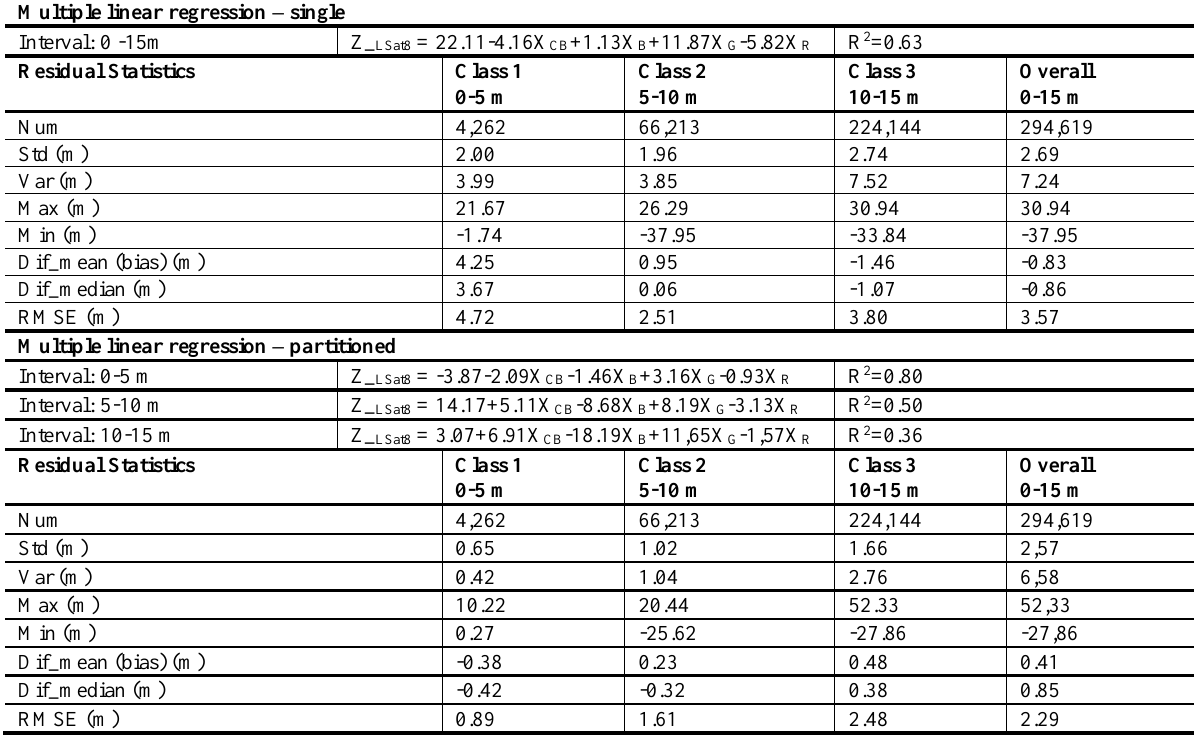
Table 1. Coefficients and residual statistics derived from single and partitioned linear regression between remote sensing reflectance and ecobathymeter